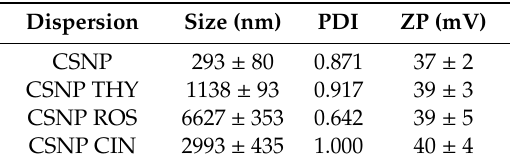
Table 1. Size (hydrodynamic diameter), polydispersity index (PDI) and zeta potential (ZP) of particle dispersions at pH